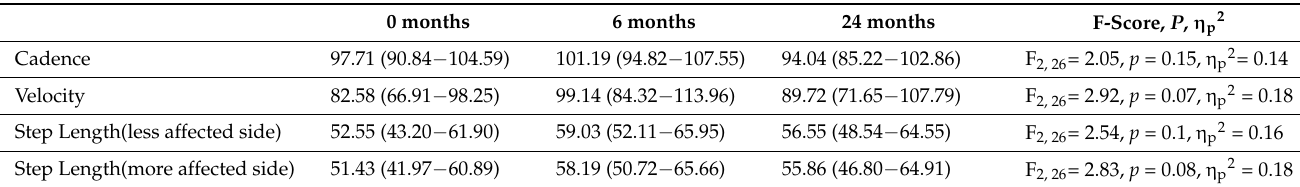
Table 2. Means, (95% Confidence Interval) of gait parameters at baseline (0 month), 6 and 24 months post-surgery.